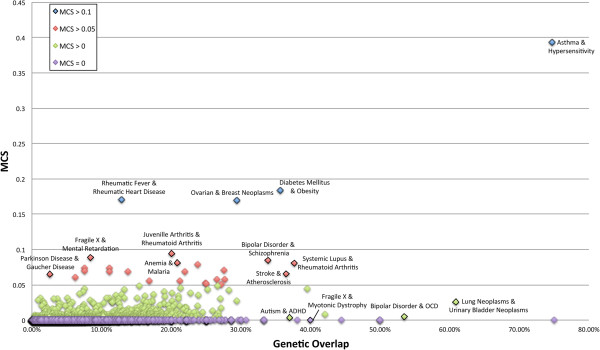
Mutual Citation Score of all disease pairs as compared with the biological association between the diseases (genetic overlap). From this figure we can conclude that degree of cooperative research between a disease pair is not always indicative of the intensity of their genetic relationship (r2=0.3187).